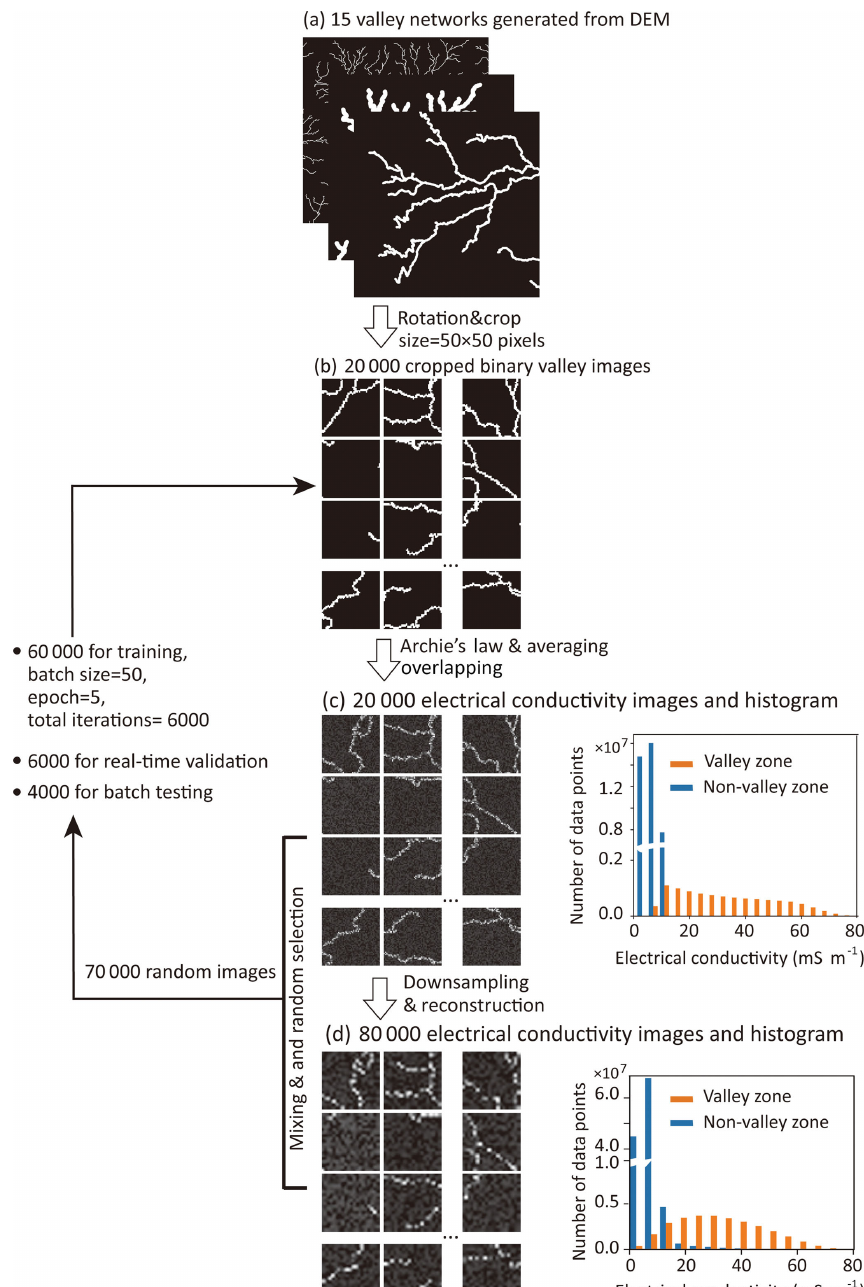
Figure 2. Workflow diagram of methodology used to generate training and validation datasets. (a) Synthetic paleovalley networks gen- erated from DEM data of the study area. (b) Rotation and cropping to randomly generate 20000 sub-images from 15 initial paleovalley networks. (c) Conversion of valley images to EC values using Archie’s law in valley and weighted averaging in non-valley zone. (d) Down- sampling of resulting 50 × 50 pixel EC spatial distributions to 10 × 10 pixel resolution (20000), 20 × 20 pixels (20000), 30 × 30 pixels (20000) and 40 × 40 pixels (20000), respectively, and reconstructed to obtain 80000 blurred EC images. A total of 70000 EC images are randomly selected from original EC images (c) and reconstructed EC images (d) , forming 70000 image pairs including 20000 binary valley images (with some EC images corresponding to the same valley image) to train the